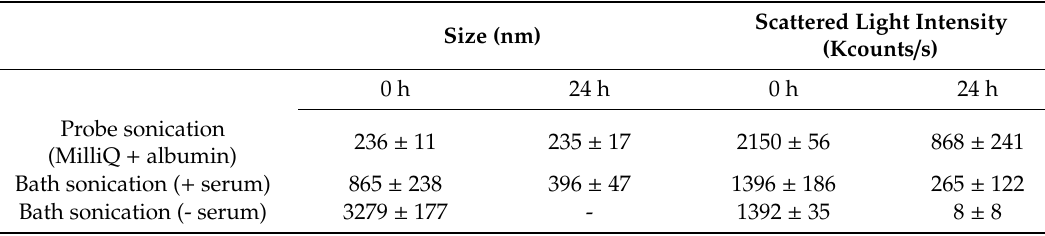
Table 2. CeO 2 size and sedimentation in cell medium. The characterization of the CeO 2 NPs was assessed using photon cross correlation spectroscopy (PCCS), following sonication of the stock suspensions using di ff erent techniques followed by dilution to 20 µ g /